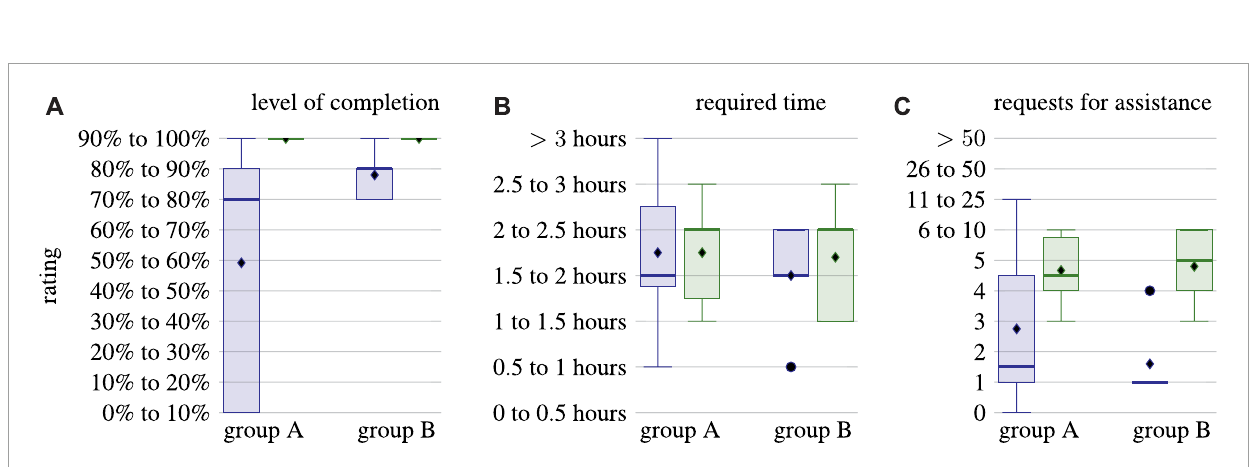
FIGURE 9 Statistical evaluation of the three additional questions of the questionnaires: self-estimated level of completion (A) , required time (B) , and number of requests for assistance (C) . Each pair of box plots depicts results for ROS (left) and µRT (right), respectively. Each axis shows results for the entire cohort (group A) and only those participants who filled in the questionnaires about ROS and µRT (group B). Vertical axes are labeled by the options participants had to choose from, as they were available in the questionnaires.